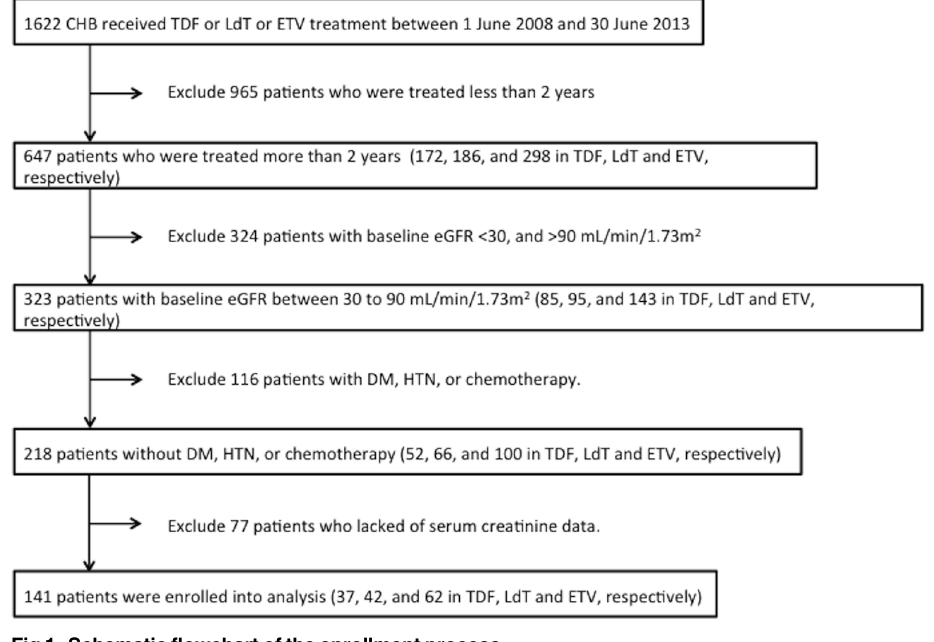
Fig 1. Schematic flowchart of the enrollment